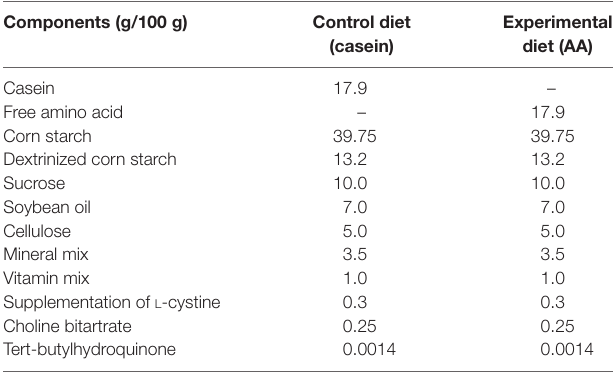
Table 1 | Composition of the control diet (CAS diet) and the experimental diet containing free amino acids (AA